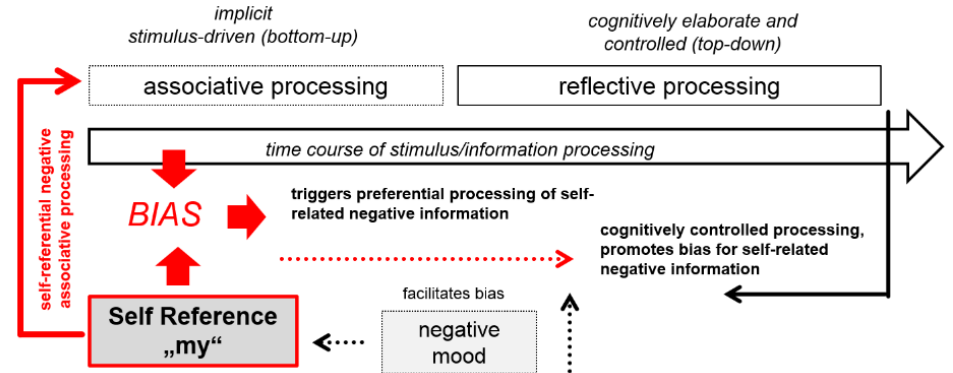
Figure 1. Information processing according to cognitive vulnerability models of depression. For further details, please see text and e.g., [10].